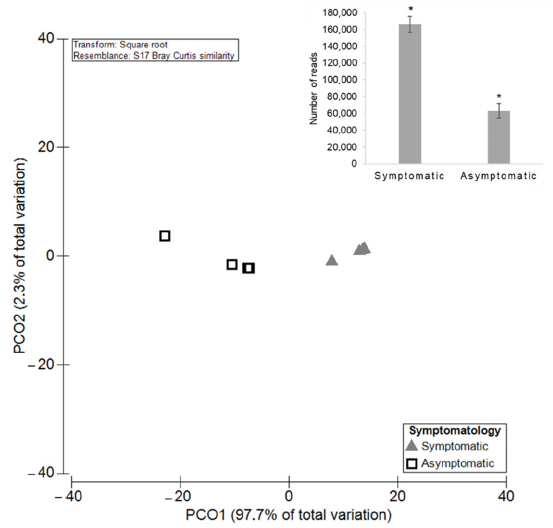
Figure 8. Principal Coordinates Analysis (PCO) based on the diversity of the endophytic fungal communities among GTDs symptomatic and asymptomatic grapevines. The average of the total number of reads for both groups is shown in bar plot and significant differences ( p < 0.05) are indicated by asterisks.